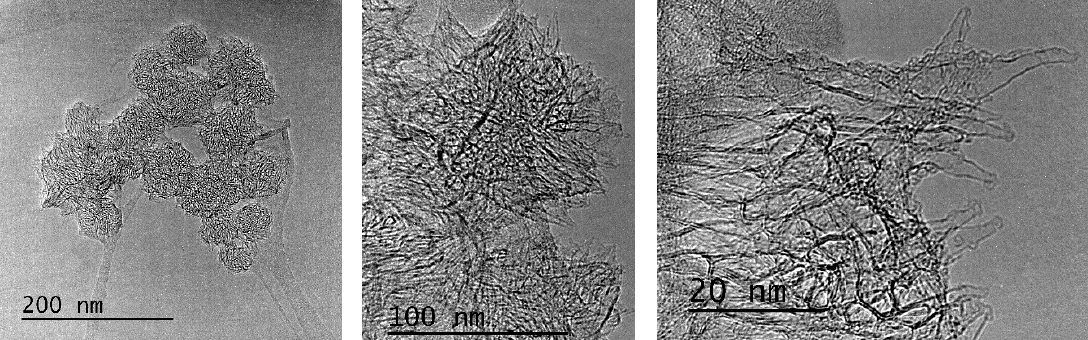
Figure 3. Synthetic route of CNH samples having adsorbed terthienyl dyes: ( A ) Synthesis of dyes ( 1 )– ( 3 ) that will form non-covalent aggregates with CNHs; ( B ) pictorial illustration of the process used to attach the dyes to CNHs.